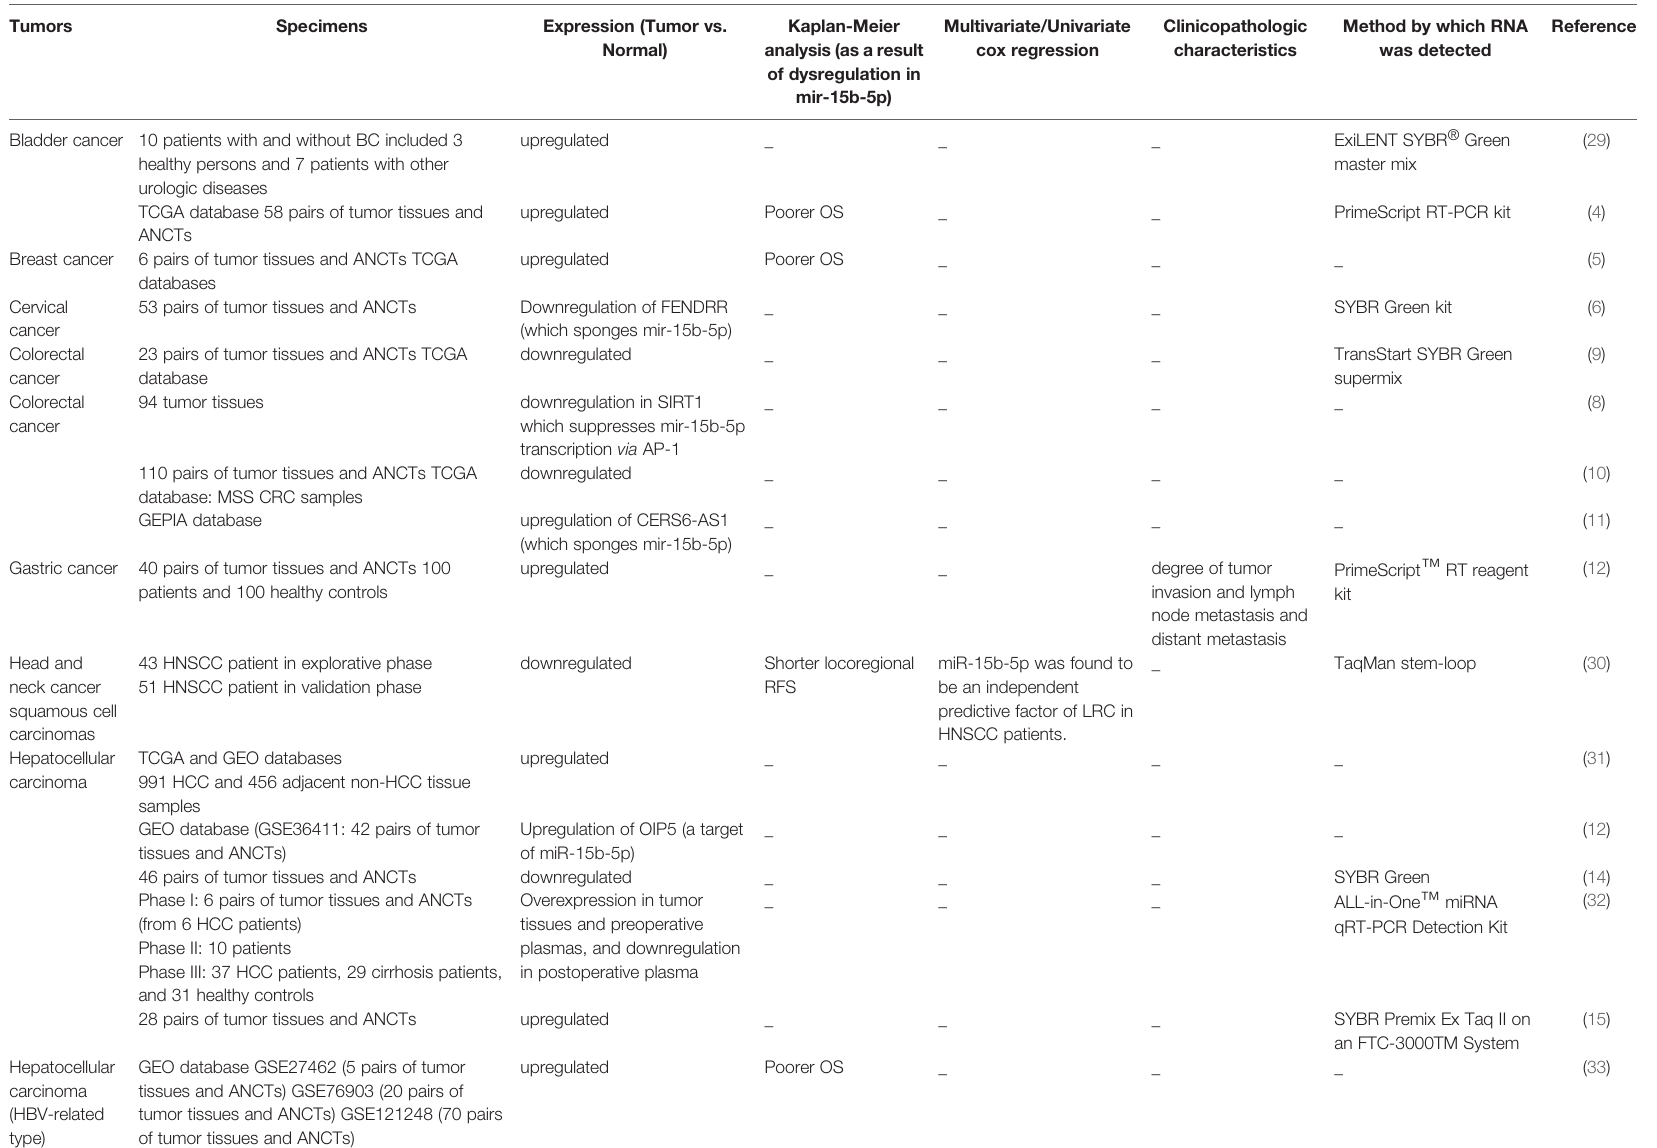
TABLE 3 | Summary of human studies on the role of miR-15b-5p in cancers (NB, Neuroblastoma; OS, Overall survival; ANCTs, adjacent non-cancerous tissues; TNM, tumor ‐ node ‐ metastasis; MSS, microsatellite stable; CRC, colorectal cancer; RFS, relapse-free survival; HCC, Hepatocellular carcinoma). Tumors